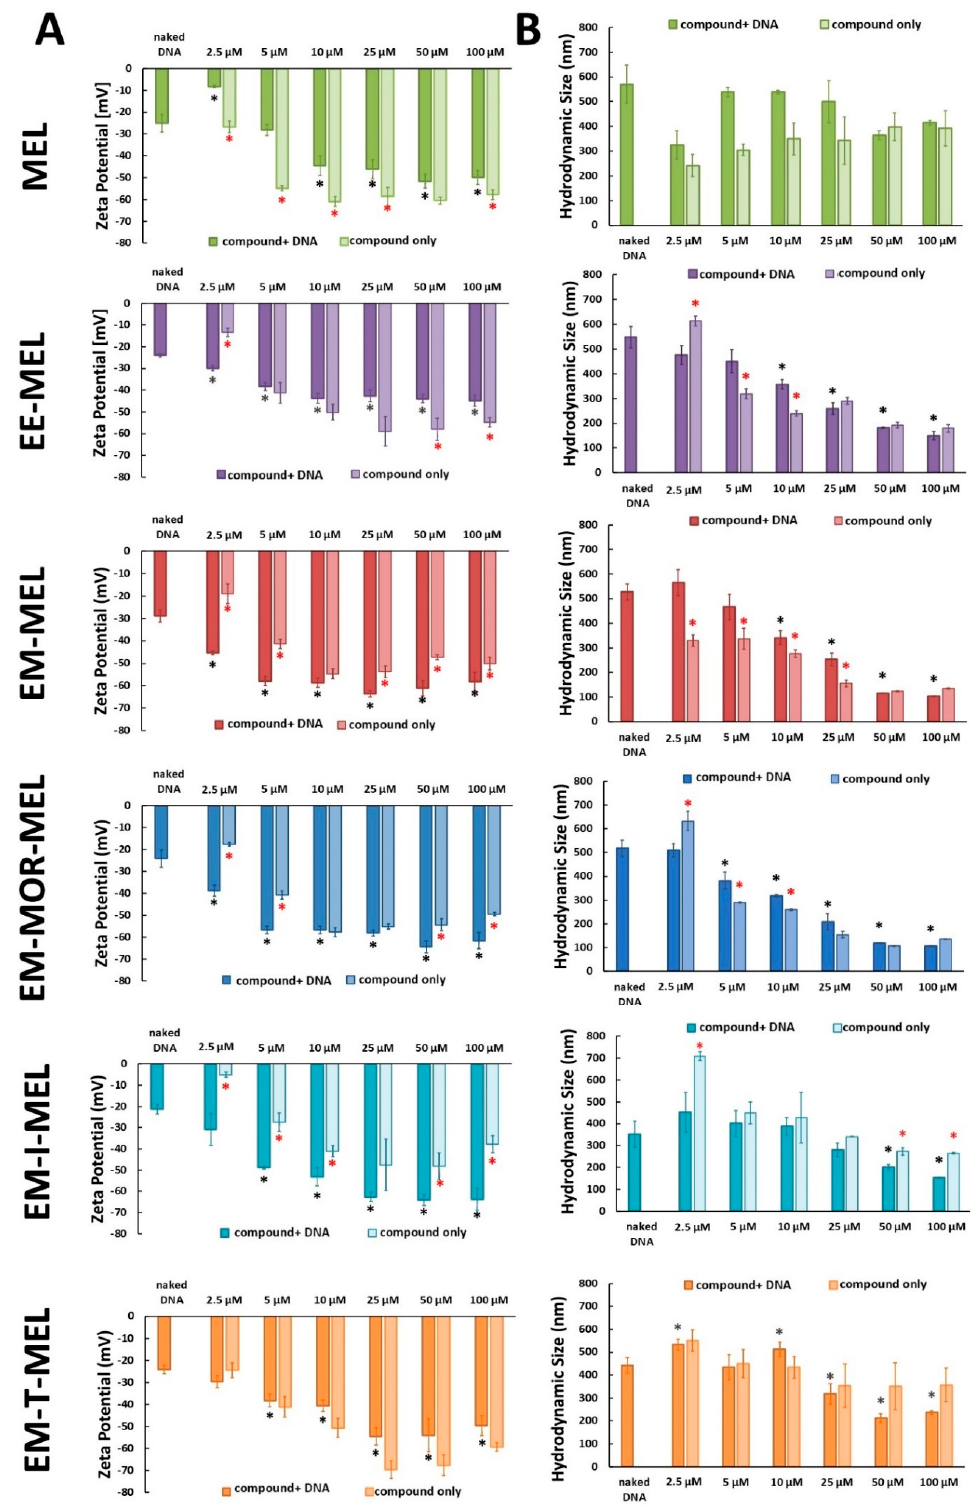
Figure 2. ( A ) Zeta potential of the original drug and all tested analogs with and without DNA. ( B ) The hydrodynamic size of MEL, EE-MEL, EM-MEL, EM-MOR-MEL, EM-I-MEL, and EM-T-MEL with and without DNA. Results are the mean ± SD. (black asterisks *) Statistically significant differences between a sample containing only DNA vs. a sample containing DNA and the tested compound, p < 0.05; (red asterisks *) statistically significant differences between a sample containing DNA and the tested compound vs. a sample containing only tested compound, p < 0.05, n =